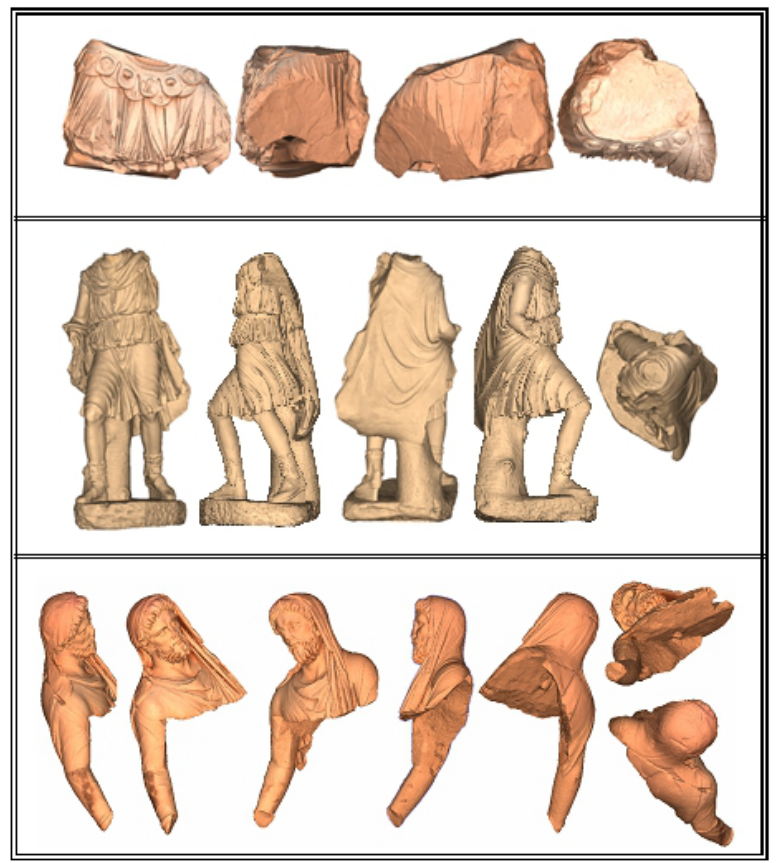
Figure 10. Final models for the three biggest pieces.